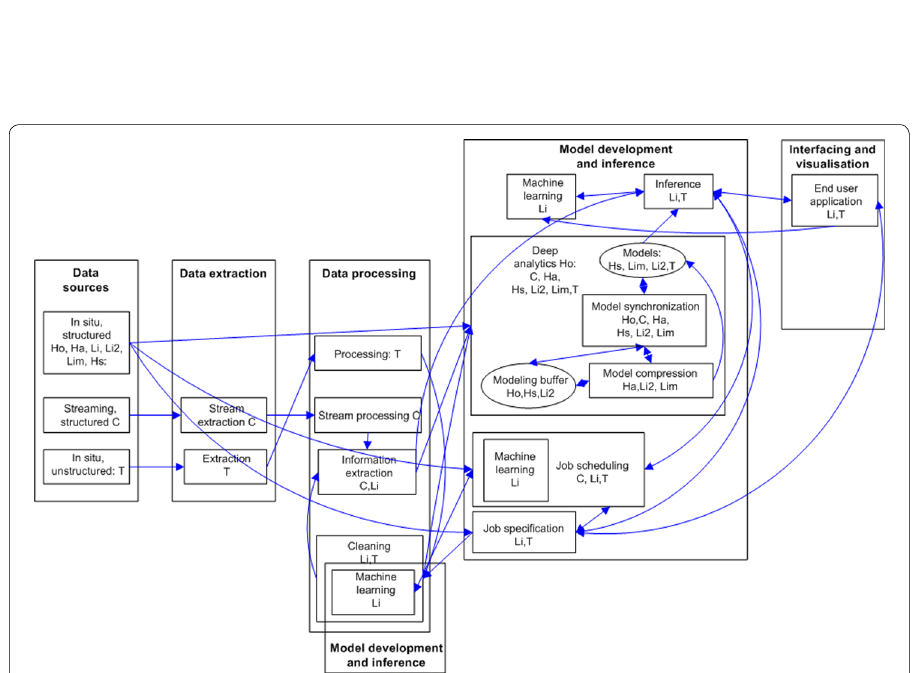
Fig. 23 Mapping of all modeling-related implementation architectures to the big data RA. Publications are referred to from the architectural elements as follows: Ho:Hong [38]; Ha:Hardy [35]; Li:Li [41]; Li2:Li2